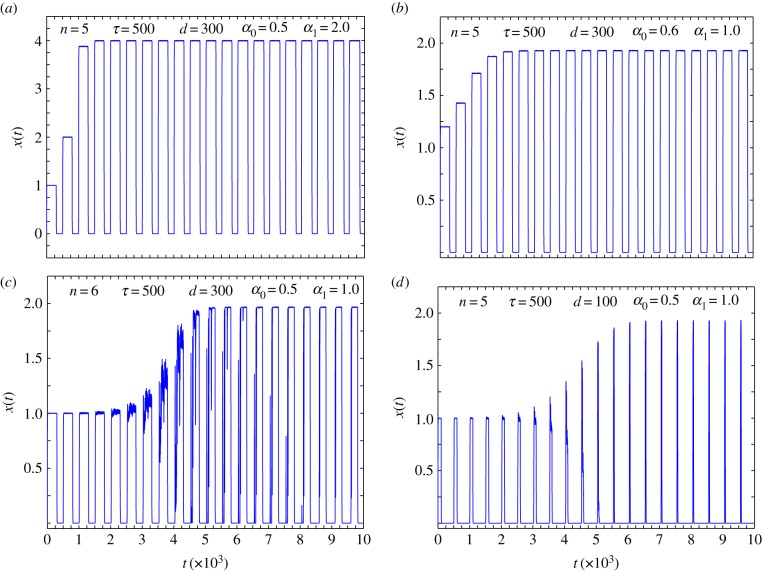
‘Area 51’ oscillations as a function of parameters. The presence of the oscillatory state for different values of the parameters α0, α1, that characterize the single-gene expression kinetics, the driving time d, delay time τ and the order of the Hill function n. (a) Presence of ‘Area 51’ states for parameter values n = 5, τ = 500, d = 300, α0 = 0.5 and α1 = 2.0. Changing the parameters α0 = 0.6 and α1 = 1.0, while keeping n, τ and d unchanged also shows oscillations as in (b). For a choice of parameters α0 = 0.5, α1 = 1.0, and n = 6 while keeping parameters τ and d same as (a) shows oscillations with accessible short lived intermediate states that lie between pluripotent and somatic fixed points. This is shown in (c). In (d) by changing the driving time to a lower value d = 100 and n = 5 while holding all other parameters same as in (c) the duration of time spent in the somatic state can be increased. (Online version in colour.)